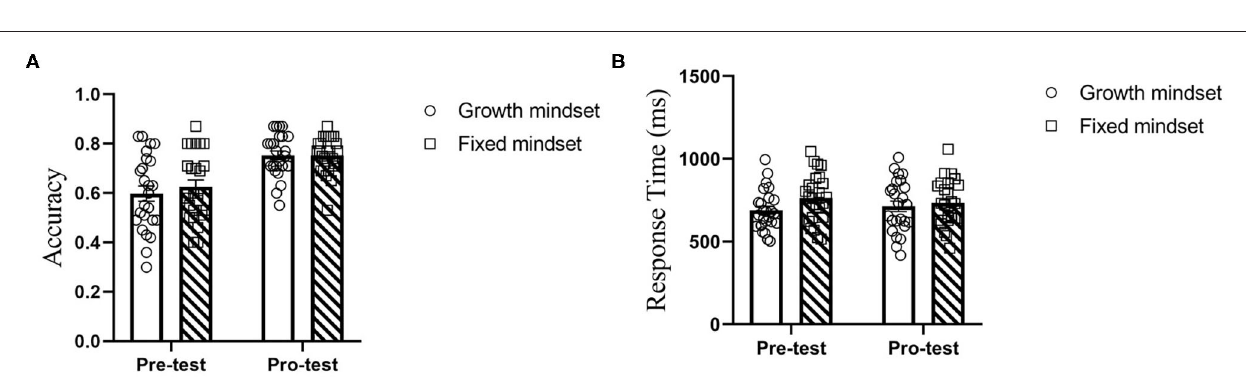
FIGURE 4 | The difference between the fixed and growth groups in working memory training tasks (animal, location, and letter).